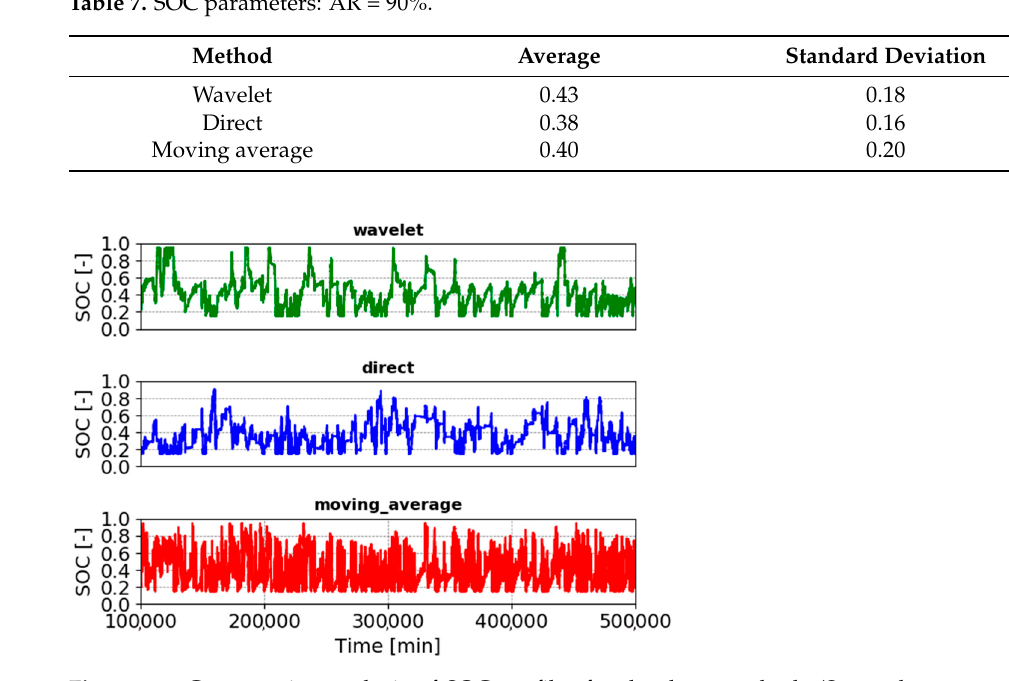
Figure 19. Comparative analysis of SOC profiles for the three methods (Same abatement ratio (AR) = 90%), wavelet capacity 330 kWh, direct capacity 460 kWh, moving average capacity 465 kWh. Table 6. SOC parameters: capacity = 330 kWh.